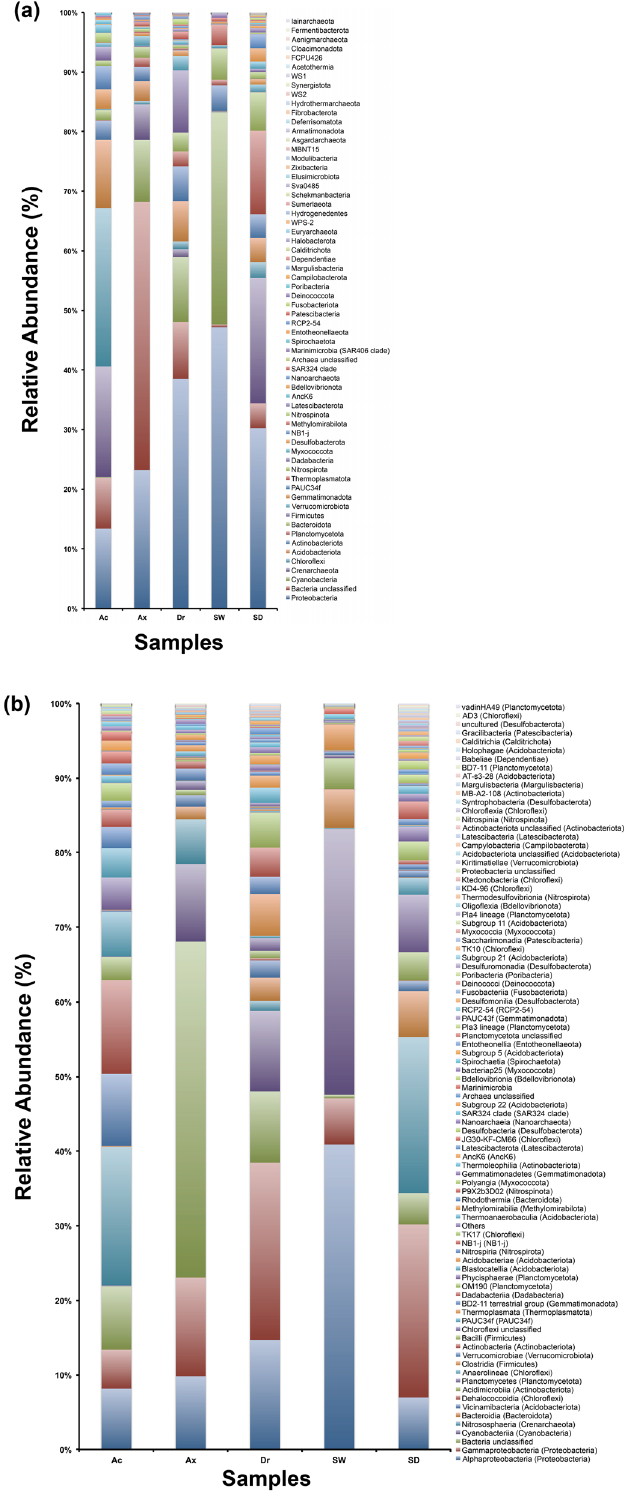
Figure 2. Phylum-( a ) and class-level ( b ) prokaryotic community composition in marine sponges, seawater, and sediment. Compositional data for Ap. caissara (Ac), Ax. corrugata (Ax), D. reticulatum (Dr), seawater (SW), and sediment (SD) are shown. Results obtained using pooled replicate samples (n = 5) within each sample category are displayed. ( a ) All 64 prokaryotic phyla are presented. ( b ) Classes with relative abundance > 0.01% are shown, while relative abundance < 0.01% are grouped within others (88